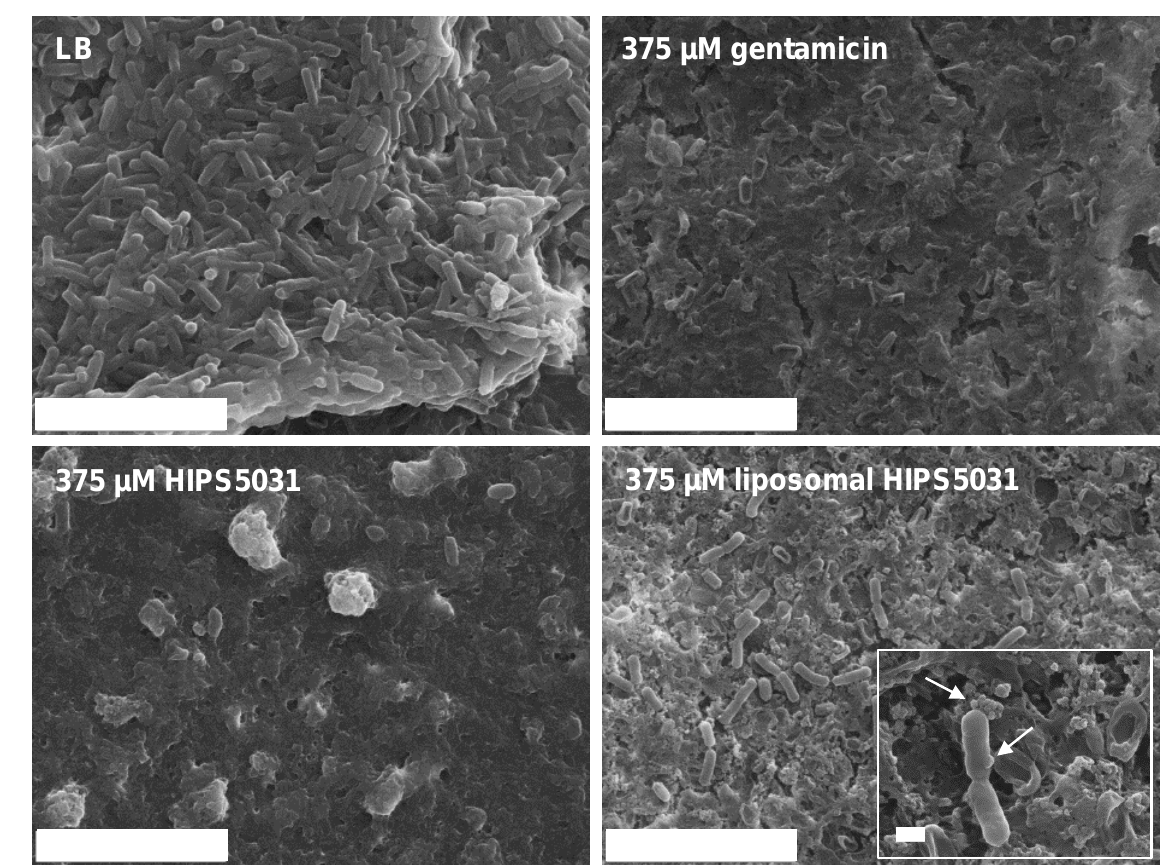
Figure 7. Scanning electron micrographs of B. subtilis 168 biofilm grown on glass coverslips in MSgg medium for 72 h prior to treatment with 375 µM of either gentamicin, HIPS5031 , or liposomal HIPS5031 and compared to the untreated control (LB). Scale bars = 9 µm. Inlet: arrows point at vesicular structures reminiscent of liposomes and adhering to the bacterial cell membrane; scale bar = 500 nm.